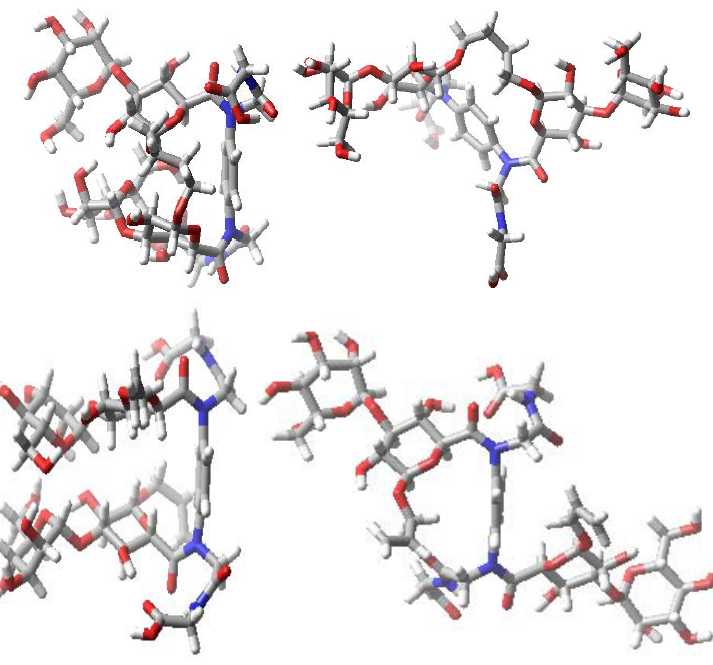
Figure 5. Stacked (left) and extended (right) conformers that can potentially be accessed by the mannose-presenting macrocyclic (top) and acyclic (bottom) glycoclusters 1 and 2